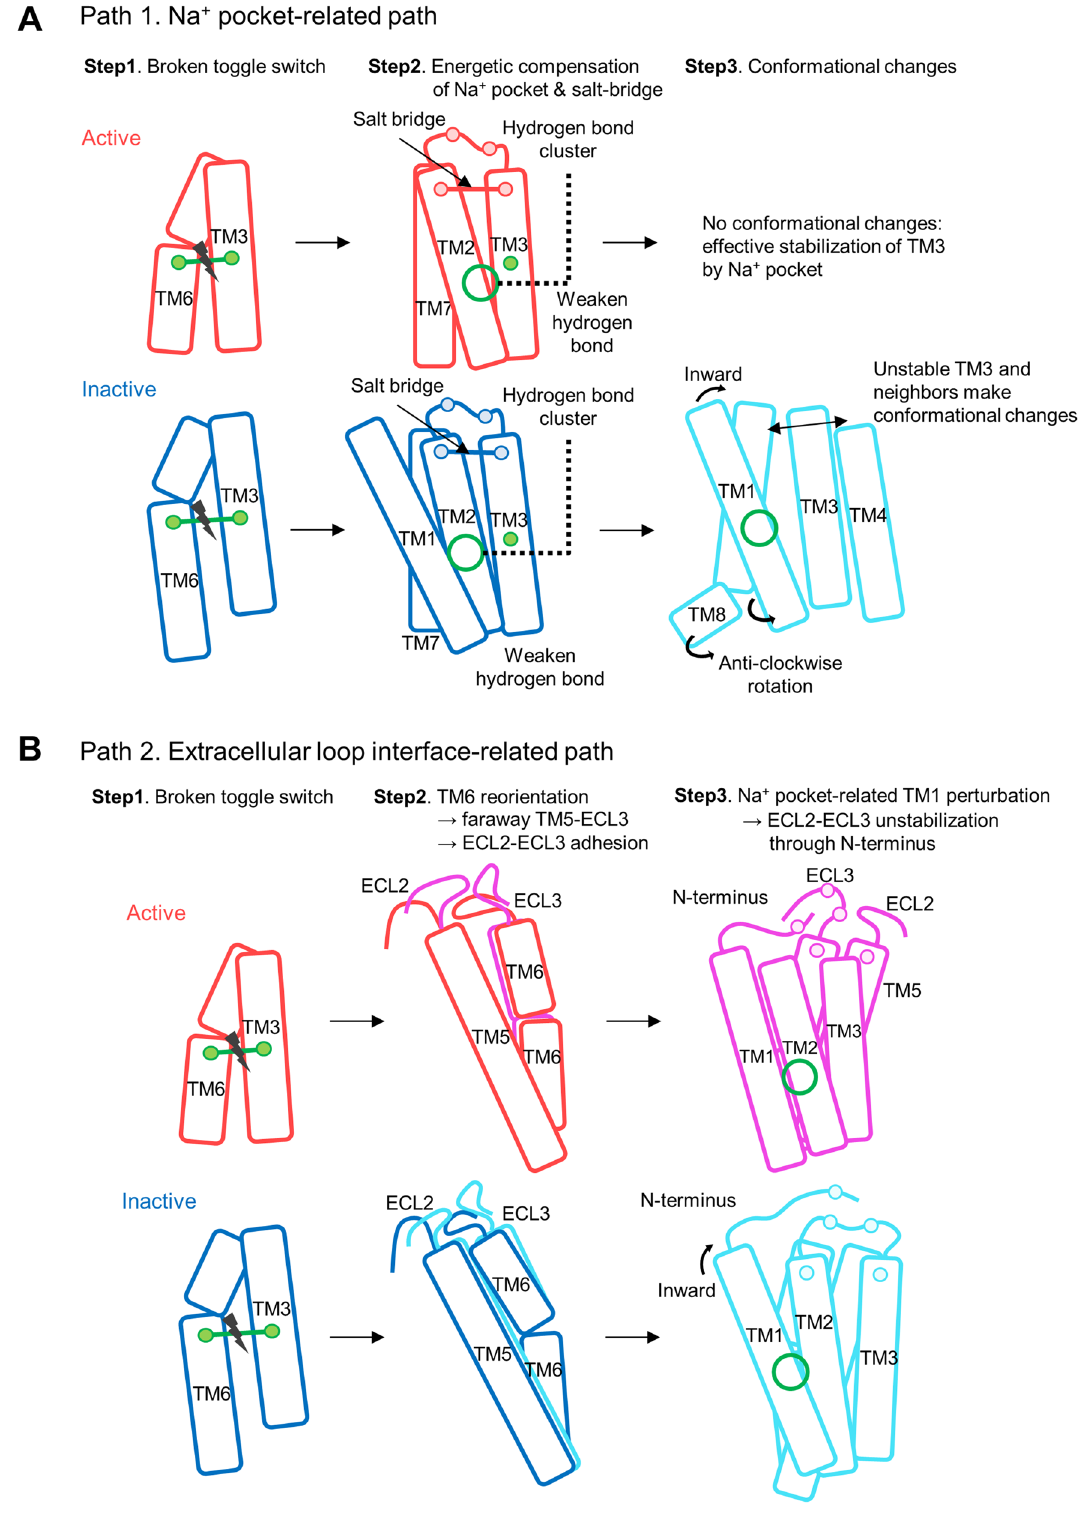
Figure 9. The effects of toggle switch mutation of CB1 related with Na + pocket and extracellular loop interfaces. ( A ) The role of Na + pocket and D2.63–K3.28 salt bridge against the destabilization of TM3–TM6 interaction by the mutation of toggle switch. ( B ) The structural changes by anti-clockwise rotation and outward shifting of extracellular TM6. Consequently, the conformational change of interaction network among ECL2, TM5, TM6, ECL3, and neighbor N-terminus of CB1 receptor is